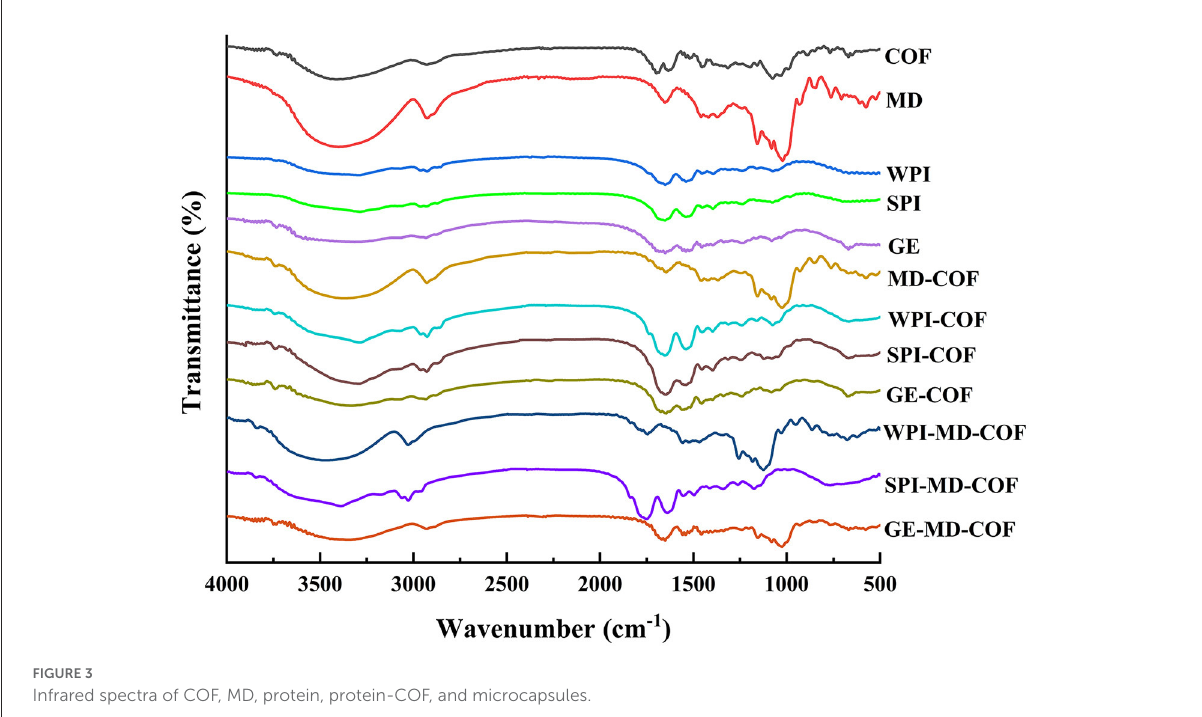
FIGURE3 Infrared spectra of COF, MD, protein, protein-COF, and microcapsules.